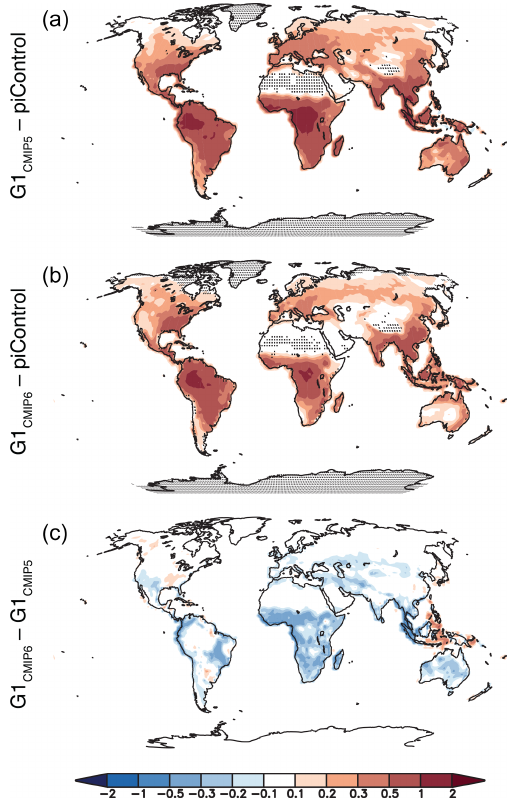
Figure 12. Terrestrial net primary productivity (kgCm − 2 yr − 1 ) for the CMIP5 (a) and CMIP6 (b) ensembles, as well as the ensemble differences (c) . All shaded values are ensemble means. Lack of stip- pling indicates agreement on the sign of the values across at least 75% of the